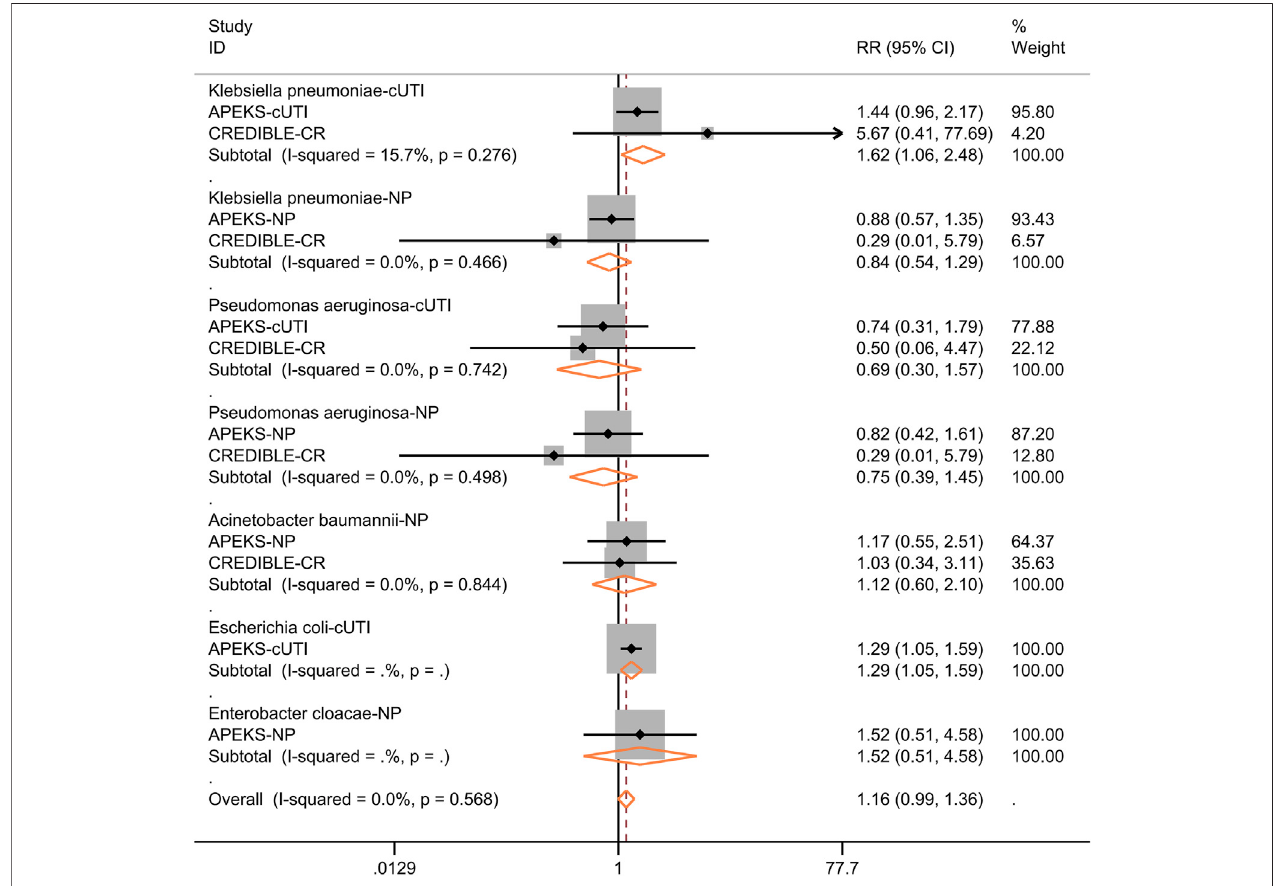
FIGURE 7 | Forest plot for the pooled analysis of microbiological eradication at test of cure between ce fi derocol and comparators for the treatment of infections caused by speci fi c pathogens. Complicated urinary tract infection, cUTI; Nosocomial pneumonia, NP.